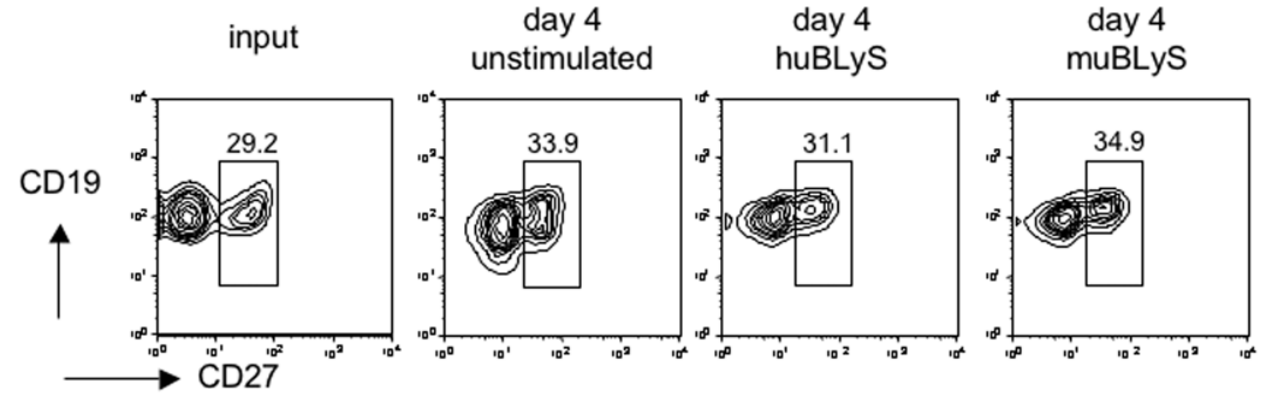
Figure 2. FACS analysis of B cell cultures. B cell populations were FACS analyzed for surface markers associated with resting B cells (CD45, CD19), memory cells (CD27), plasma cells (CD38) and kappa and lambda light chains on the day of isolation and after 4 days of culture either unstimulated or stimulated with human or murine BLyS. All samples were initially gated for lymphocytes by forward and side scatter. Data representative of 4